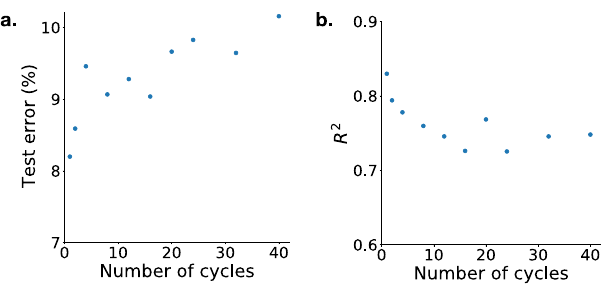
Fig. 4 | Multi-step forecasting. Our model can also forecast longer term battery performance, as quanti fi ed by ( a ) % test error, and ( b ) R 2 value. Given the EIS spectrum and knowledge of the next protocols that will be applied to the cell, the discharge capacity is predicted with a test error of less than 10% up to 32 cycles in advance.